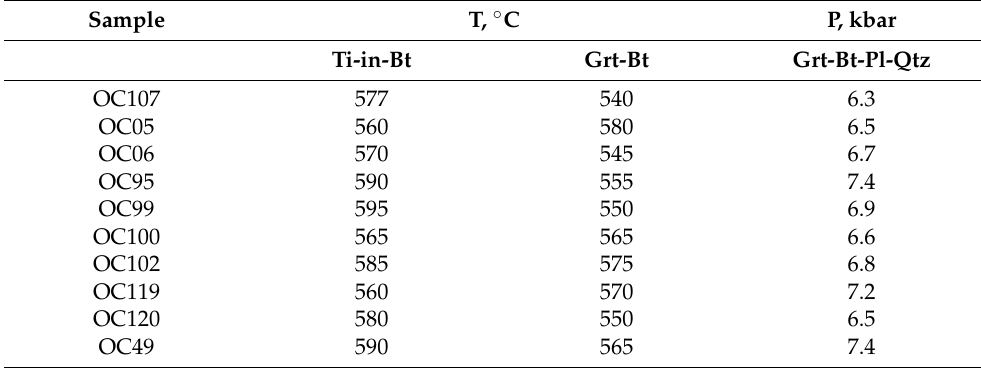
Table 4. P-T parameters of metamorphism of garnet-biotite schists of the Olympiada deposit.